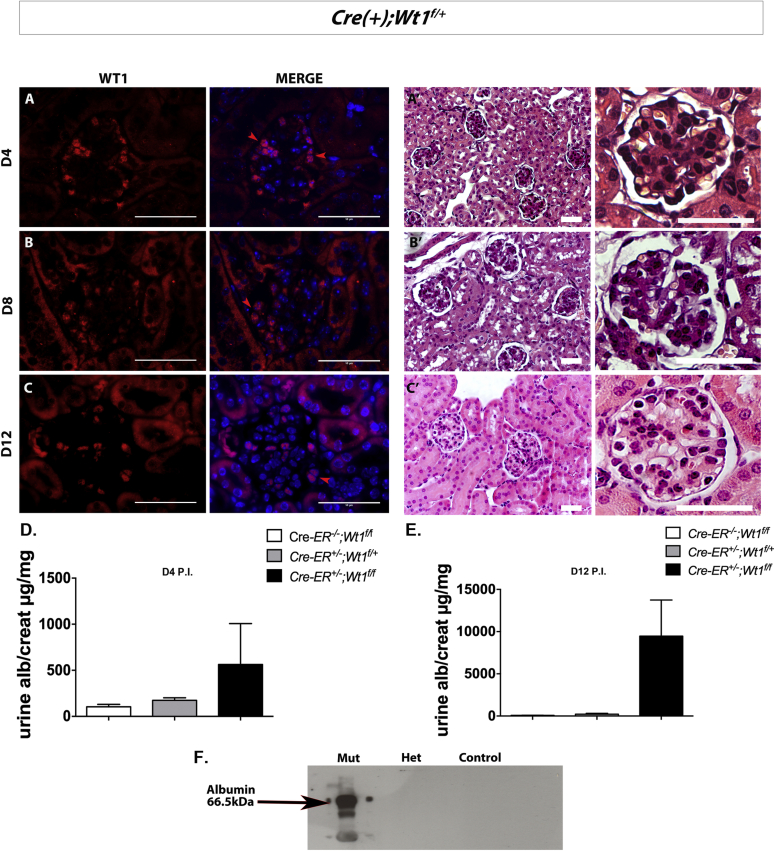
Wilms’ tumor 1 (WT1) is expressed in Cre(+);Wt1f/+ transgenic mice postinduction (PI) of tamoxifen. (A-C) Representative micrographs of glomeruli following immunofluorescent labeling of podocytes with anti-WT1 antibody in day (D) 4, D8, and D12 Cre TM+/−;WT1f/+ heterozygotes PI. Bars = 50 μm. (A) At D4 PI, WT1 protein is expressed in CreTM+/−;Wt1f/+ glomeruli following tamoxifen induction, as indicated by arrows. (B) WT1 protein expression is present at D8 PI in the heterozygotes, as seen by the arrows. (C) By D12 PI, WT1 protein is still present in the heterozygotes. (A′,B′) Hematoxylin and eosin–stained sections of glomeruli at D4, D8, and D12 PI. Bar = 25 μm. (A′) Mice exhibit healthy glomeruli with no histological abnormalities at D4 PI. (B′) At D8 PI, no hyaline presence or glomerulosclerosis and glomeruli are intact. (C′) No histological abnormalities in the glomeruli by D12 PI with no hyaline material in either the glomeruli or tubules. (D) Quantitative graph showing mean urine albumin-creatinine ratio (μg/mg) at D4 PI controls versus heterozygotes versus mutants (n = 14 vs. n = 8 vs. n = 10): 104.4 ± 25.7 versus 174.9 ± 27.0 versus 563.5 ± 443.9, P = 0.21, Student t-test. (E) Quantitative graph showing mean urine albumin-creatinine ratio (μg/mg) at D12 PI controls versus heterozygotes versus mutants (n = 8 versus n = 3 versus n = 7): 76.8 ± 13.9 versus 223.5 ± 93.8 versus 9469 ± 4279, P = 0.21, Student t-test. (F) Western blot analysis of urine samples of CreTM−/−;Wt1f/f, CreTM+/−;Wt1f/+, and CreTM+/−;Wt1f/f at D8 PI probed with anti-albumin. Albuminuria is detected in the mutant and absent in both controls (molecular weight of albumin: 66.5 kDa).